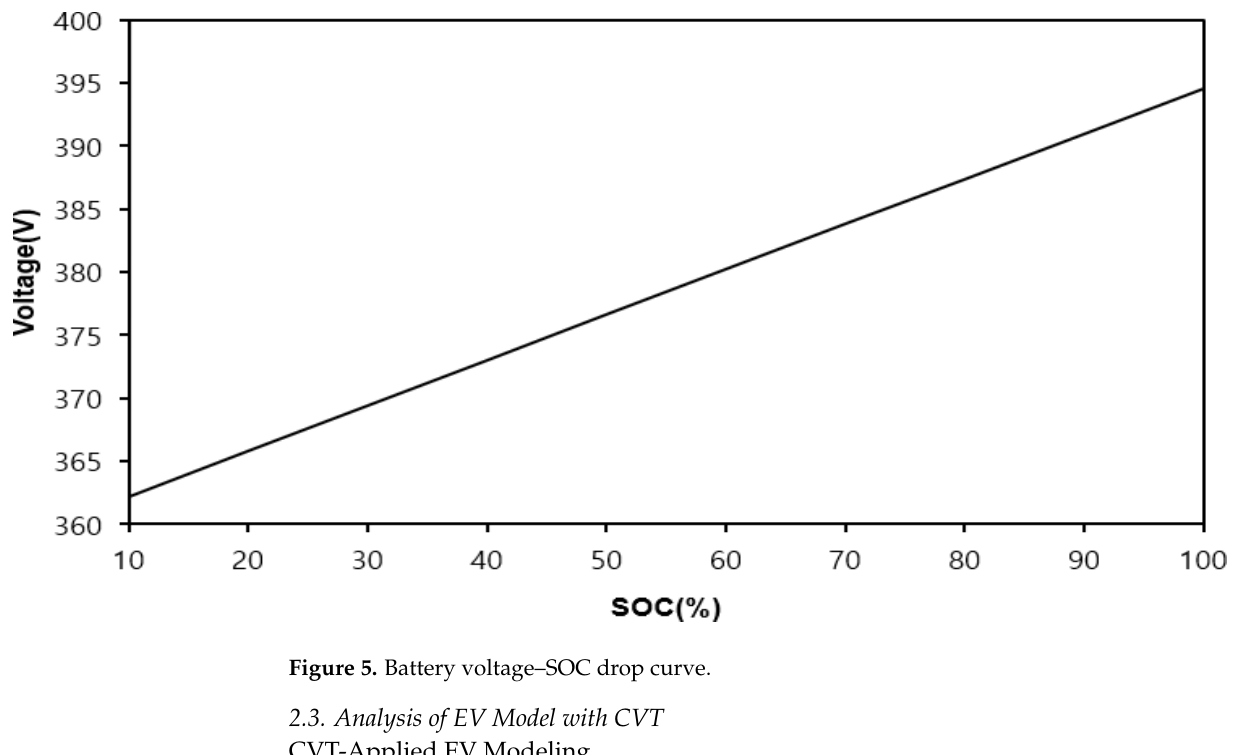
Figure 4. Comparison of motor torque–output.